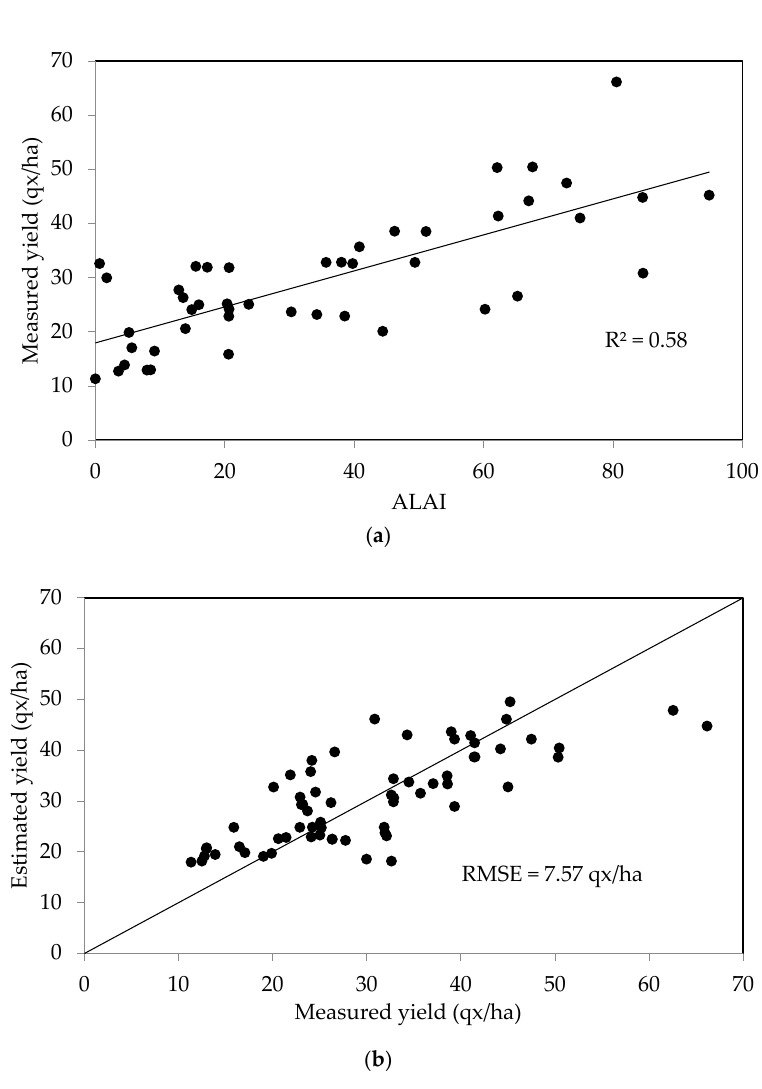
Figure 8. ( a ) Relationship between measured cereal grain yields and A LAI ; ( b ) Measured grain yields compared with yield estimates, computed using the maximum growth period LAI, for two test plots and two crop years.